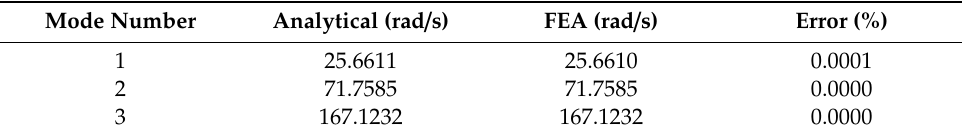
Table 2. The first three natural frequencies of the